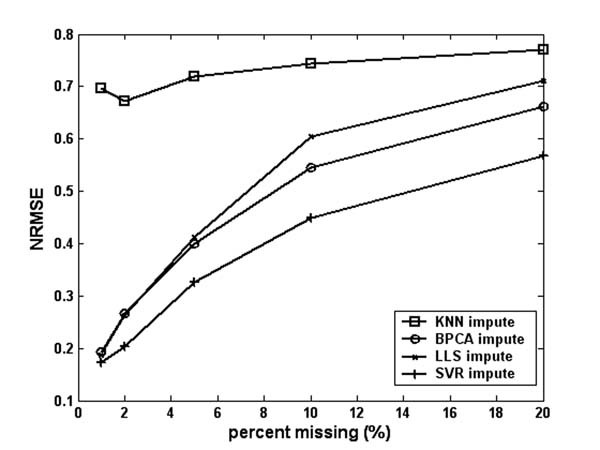
Performance of the four methods on data A. The percentage of entries missing in the 'complete matrix' and the NRMSE of each missing value estimation method are shown in the horizontal and vertical axes, respectively.